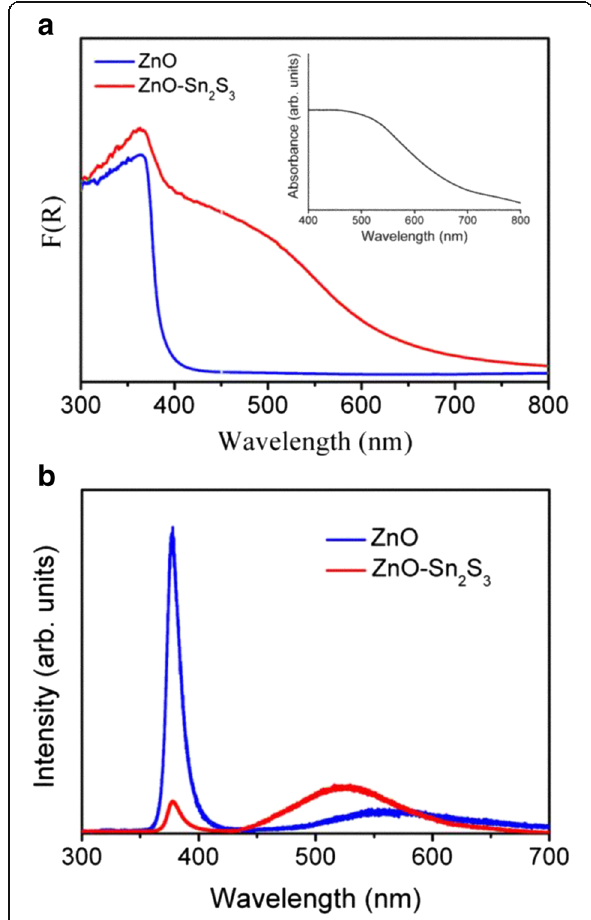
Fig. 4 a Optical absorbance spectra of the ZnO and ZnO – Sn 2 S 3 nanorods. The inset shows the optical absorbance spectrum of the Sn 2 S 3 film. b PL spectra of the ZnO and ZnO – Sn 2 S 3